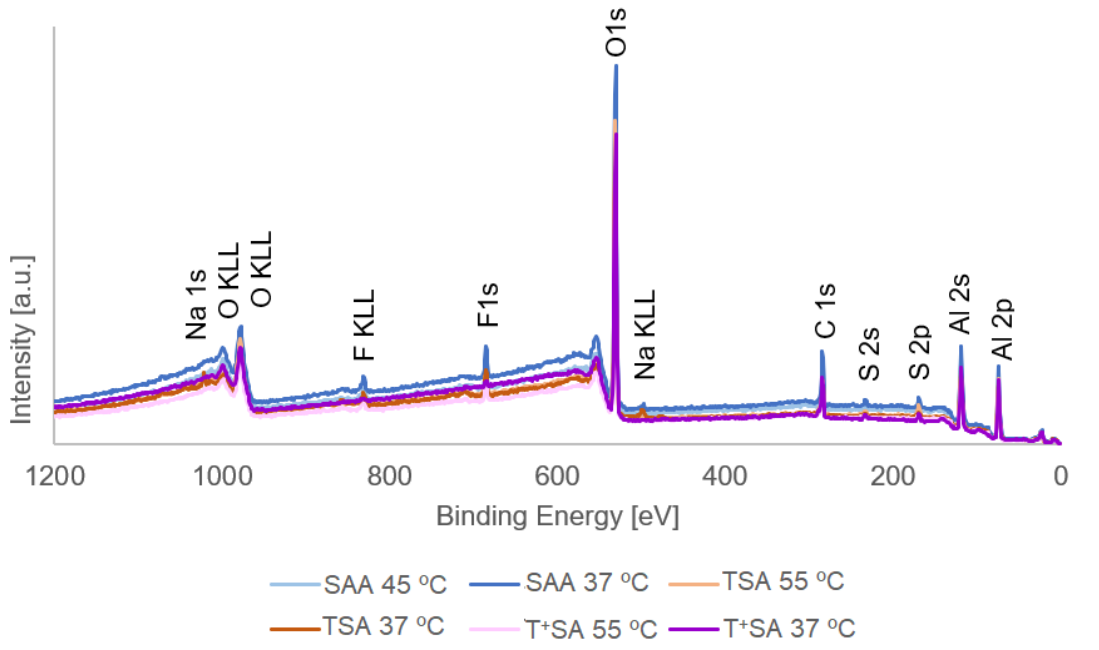
Figure 6. XPS survey scans of the six barrier anodic oxide films under study.